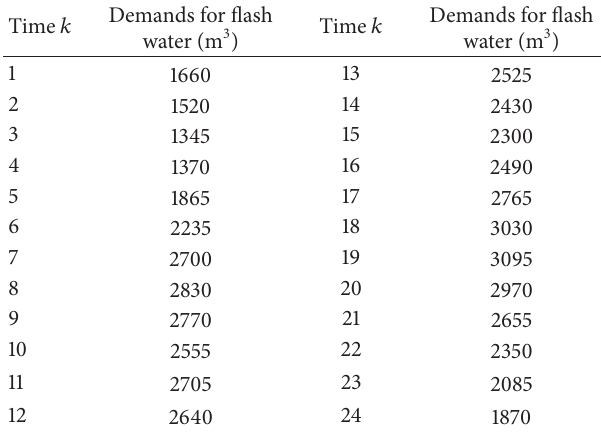
Table 2: The user’s demands for freshwater 𝐷 ( 𝑘 ).